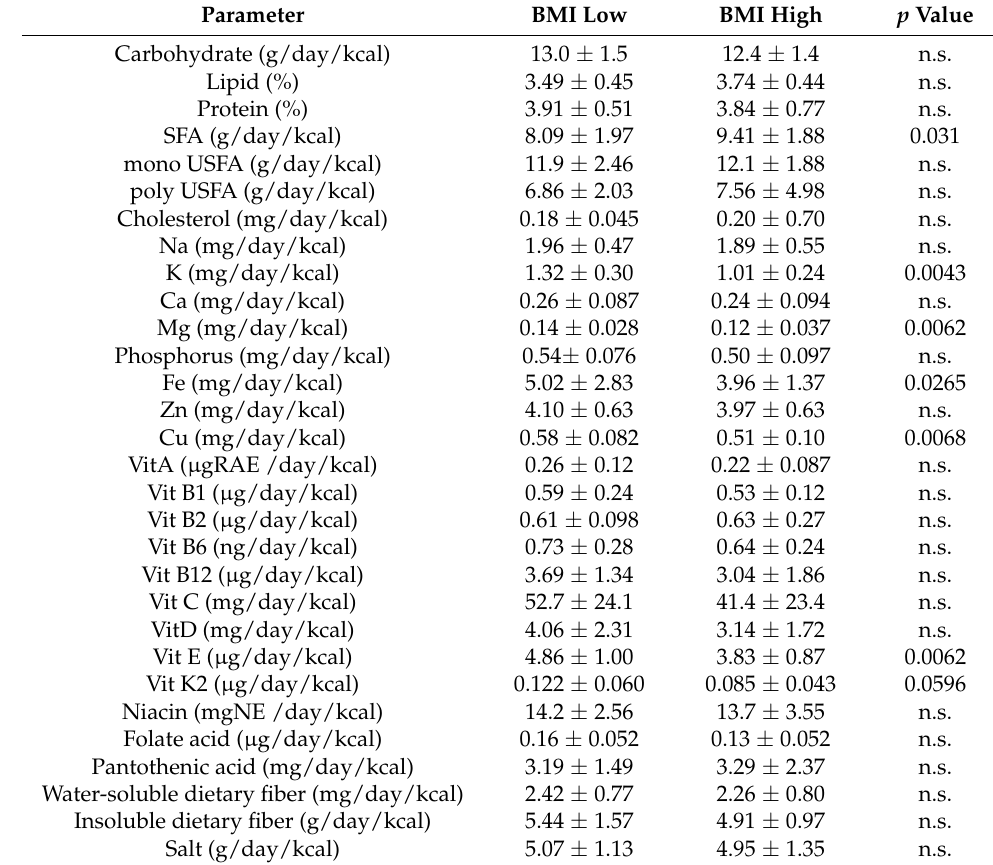
Table 8. Comparison of the ratio of each nutrient to total caloric intake (BMI Low group, BMI High